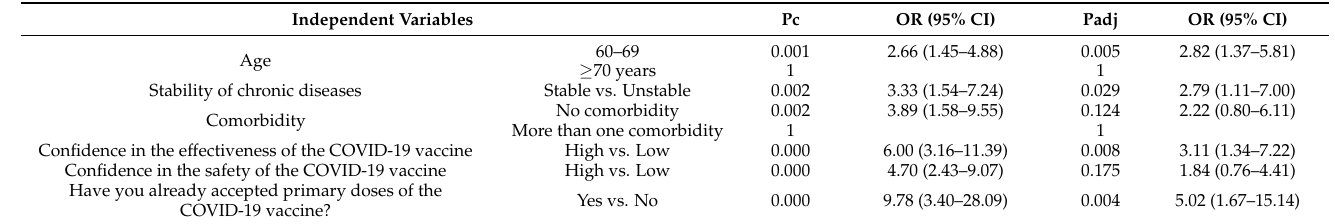
Table 3. Logistic regression of factors associated with willingness to accept a booster dose of COVID-19 vaccine, n = 254.